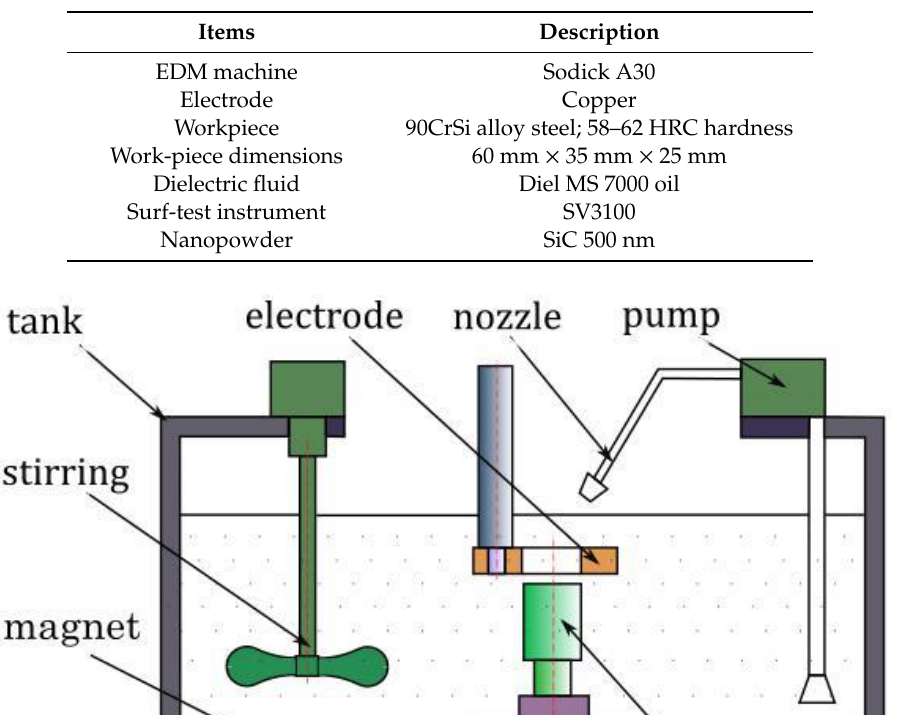
Figure 3. The electrode for PMEDM process. Table 3. PMEDM process information.